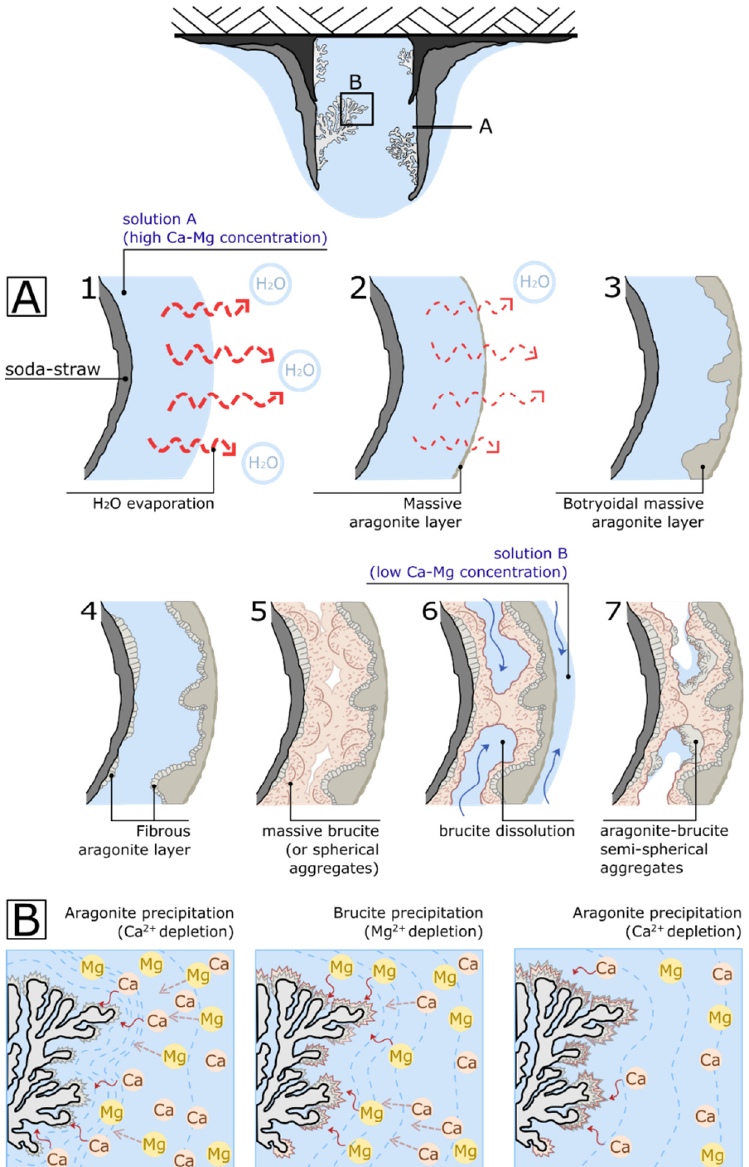
Figure 6. Sketch of the suggested genesis of the studied stalactite. The final obtained structure corresponds with that market in Figure 4a (white square). ( A ) sequence of the formation of the cone-crust. ( B ) Formation of the branching of coralloids (blue dished lines represent solute concentration isopleths).